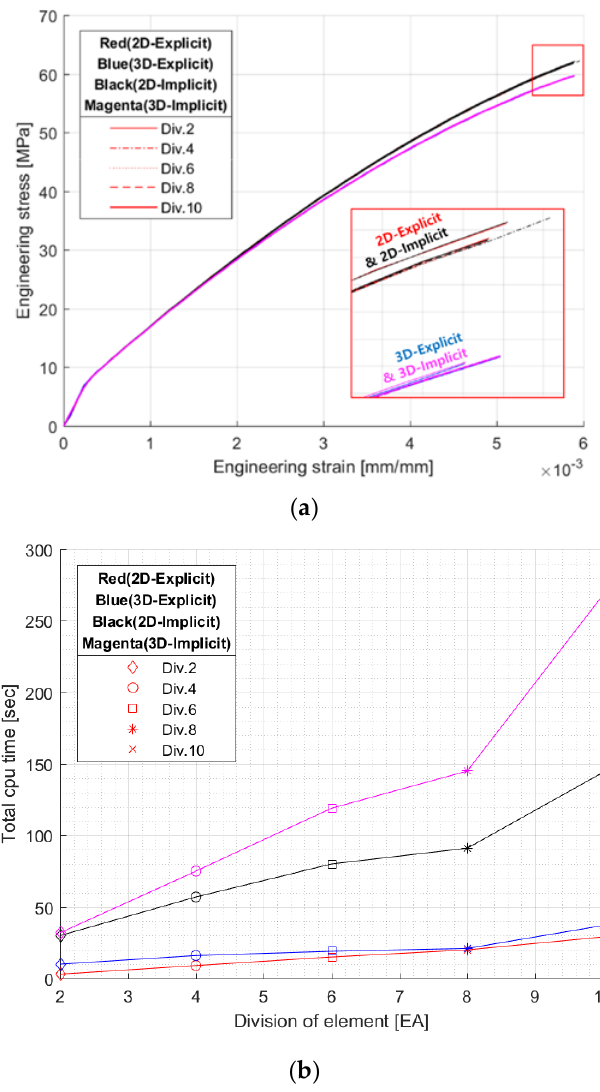
Figure 5. Results of the finite element analysis: ( a ) result of the finite element analysis; ( b ) total CPU time by element type and solver type.